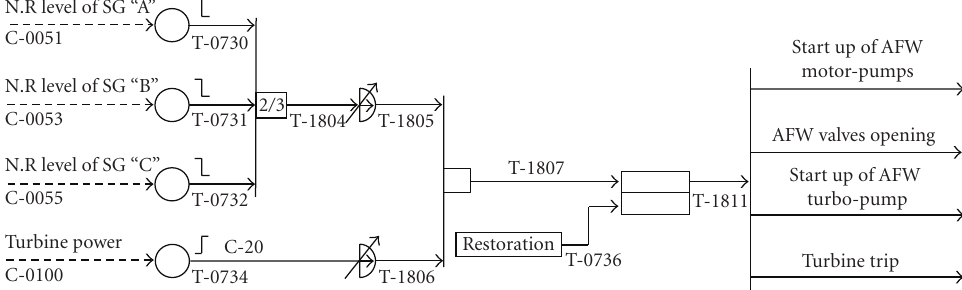
Figure 8: Logic diagram of the AMSAC system.